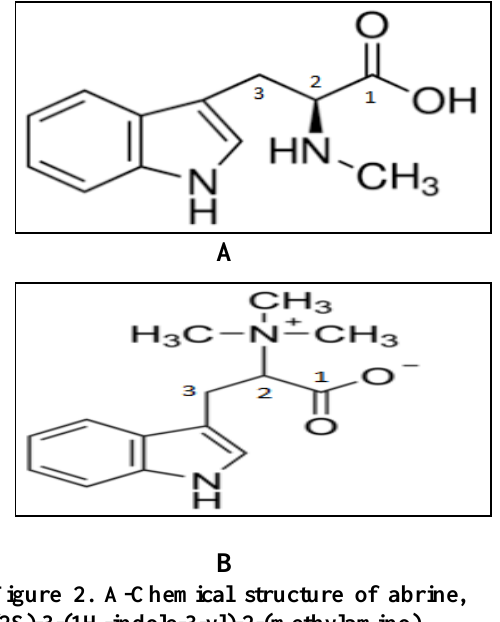
Figure 2. A-Chemical structure of abrine, (2S)-3-(1H-indole-3-yl)-2-(methylamino) propionic acid, (C 12 H 14 O 2 N 2 ) (21) , B-Figure (1.4): Chemical structure of hypaphorine, (3S)-3-(1H-indole-3-yl)-2-(trim ethyl azaniumyl) propionate, (C 14 H 18 O 2 N 2 ) (22) . Material and methods Plant collection The plant was authenticated by